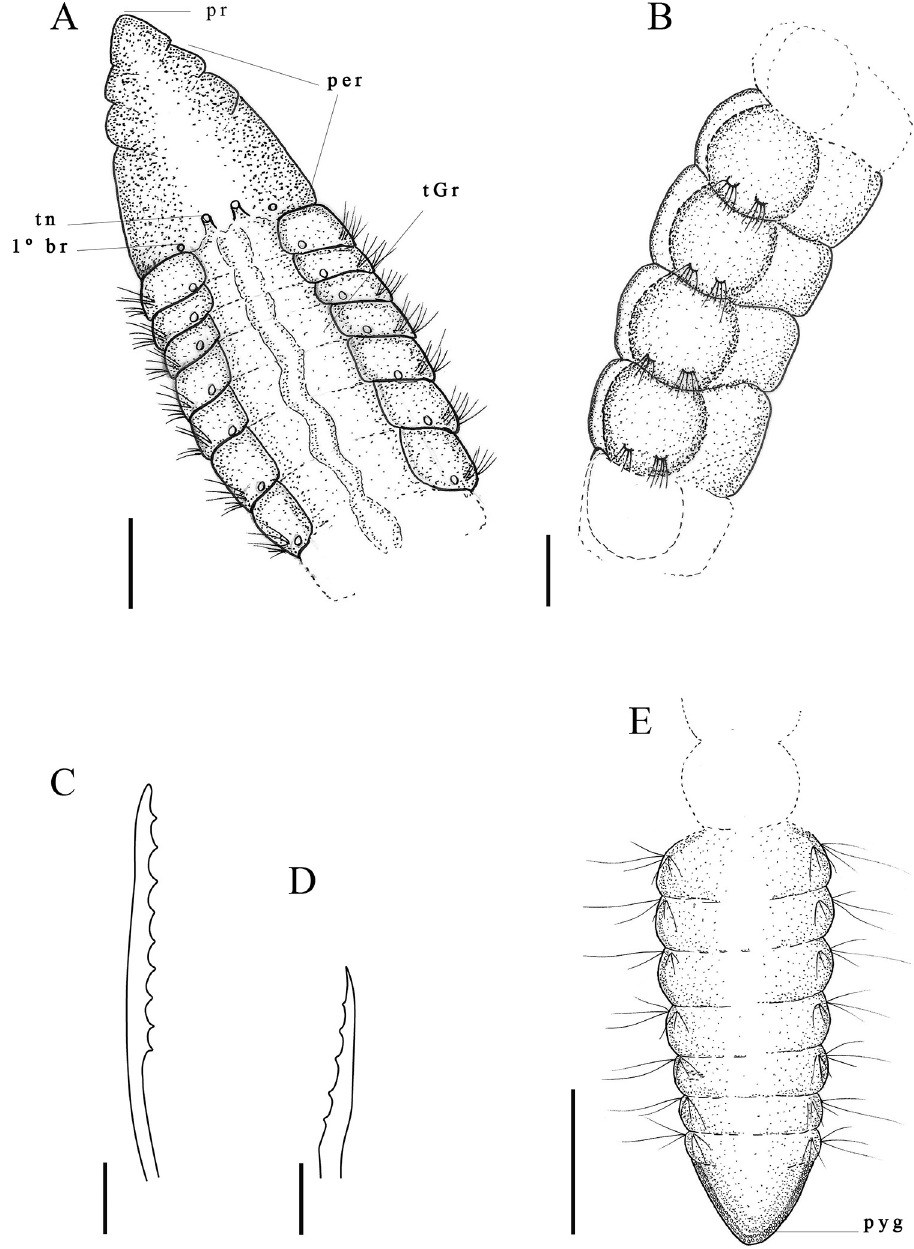
Fig 4. Kirkegaardia brisae sp. nov. (A) anterior end, dorsal view; (B) abdominal segments, lateral view; (C) notopodial capillary denticulated; (D) neuropodial capillary denticulated; (E) posterior end, dorsal view. A–E (MNRJP-002974). Scale bars: 100 μ m (A B and E); 10 μ m (C-D). Type locality. Atlantic Ocean: Campos Basin (Brazil). Habitat. Frequent in sandy sediments, rarer in muddy or sediments with gravels and rhodoliths, 14 to 352 m depth. Distribution. Presently known only from Atlantic Ocean: Campos Basin (Brazil). Methyl Green. No pattern, stain not retained. to 38. Abdominal neurosetae smaller than notosetae in first abdominal segments, noto- and neurosetae of same size in middle segments of abdominal region. Pre-pygidial segments and pygidium absent.